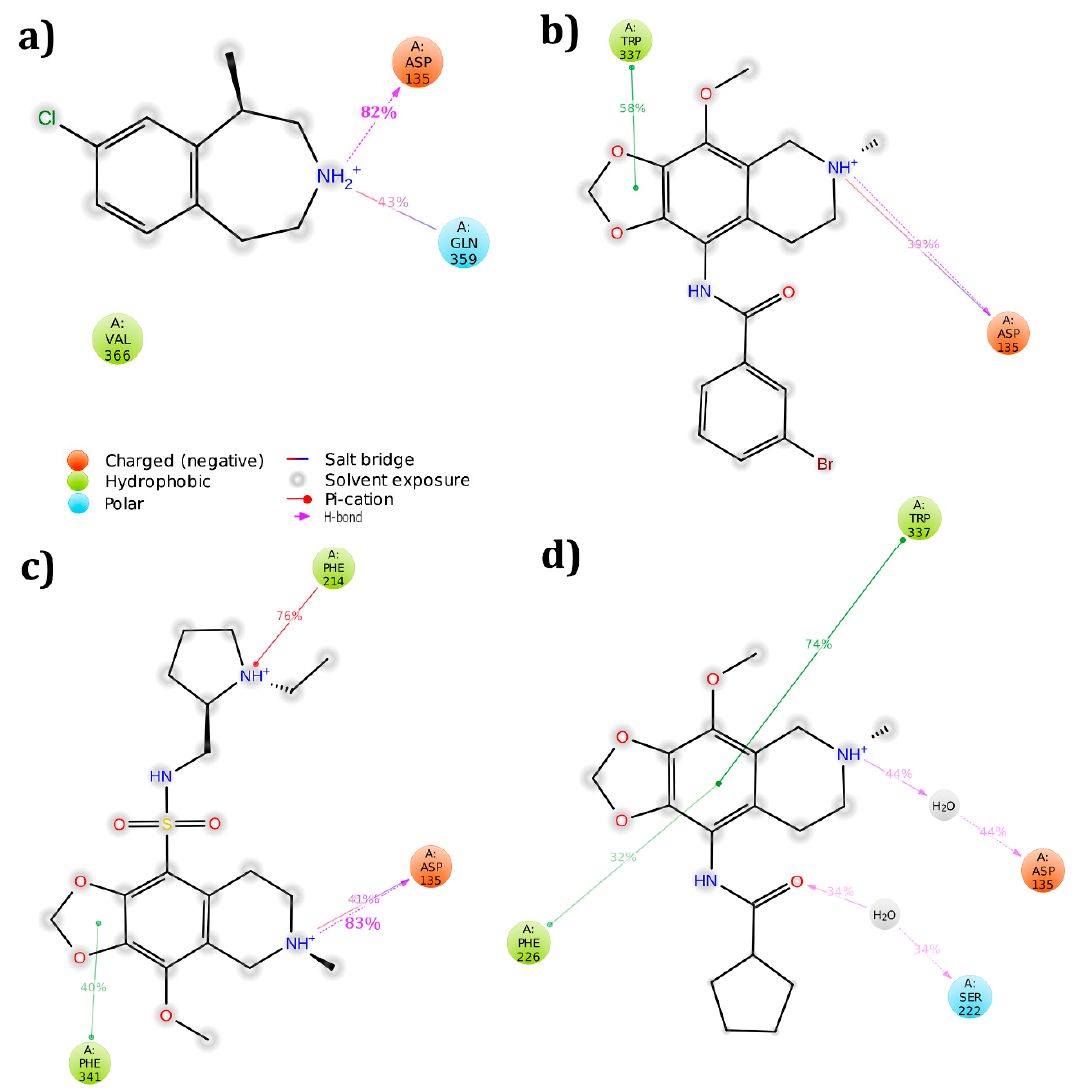
Figure 6. 5HT 2B receptor amino acids interaction profiles with molecules after completion of simulation run: ( a ) Lorcaserin; ( b ) ZINC32123870; ( c ) ZINC40312983; and ( d )